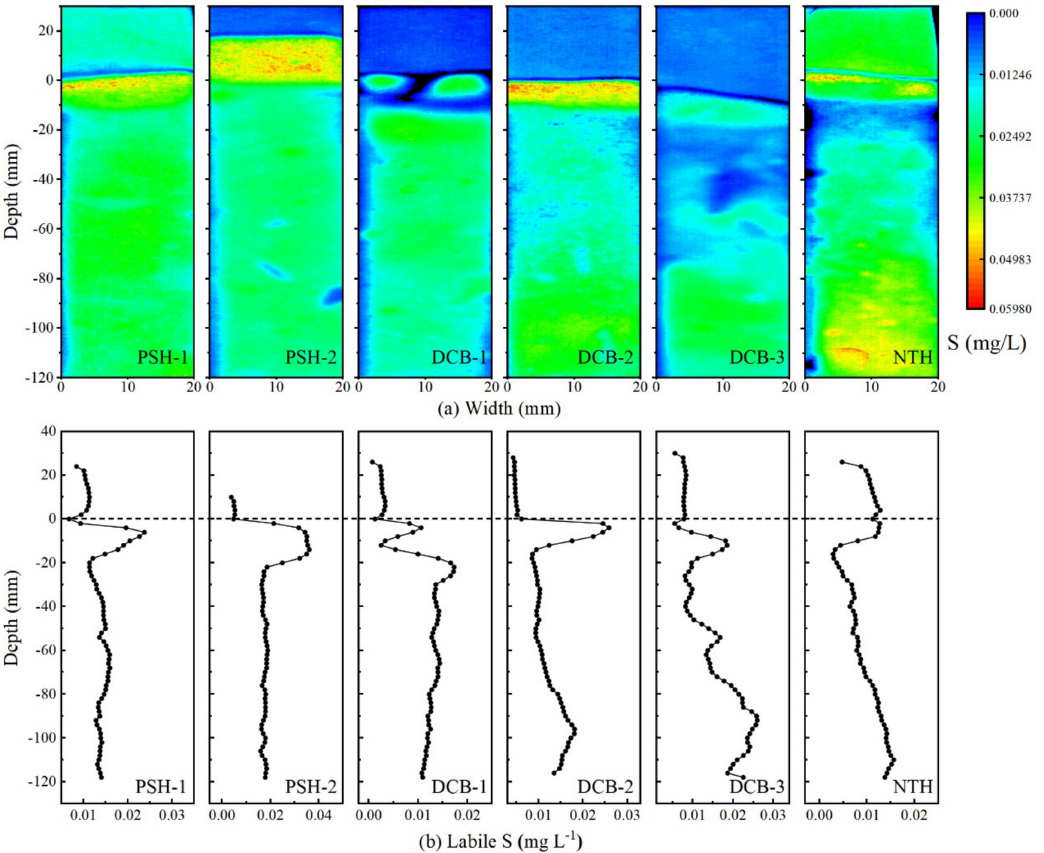
Figure 3. One-dimensional distribution ( b ) and two-dimensional distribution ( a ) of labile S. The dotted lines at a depth of zero show the position of the